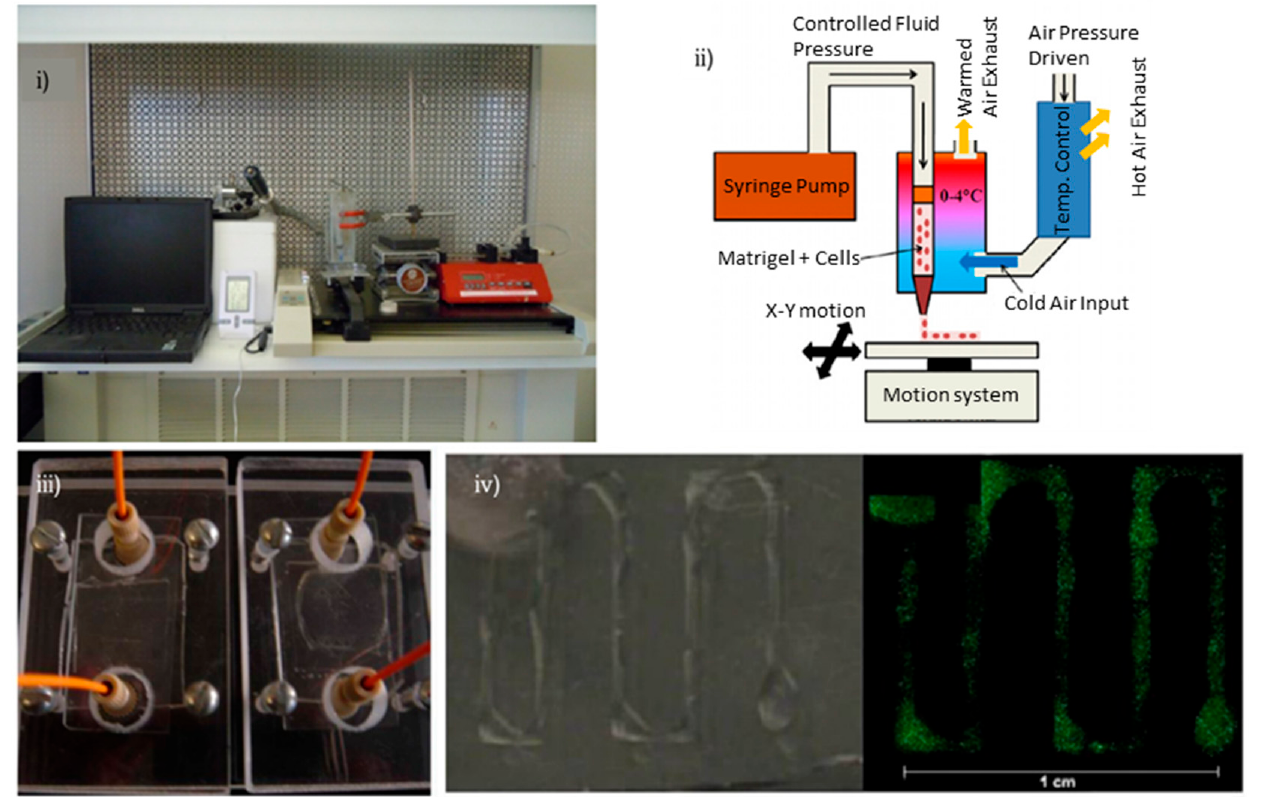
Figure 7. Bioprinted liver-on-chip for drug conversion and radiation protection studies: ( i ) photograph and ( ii ) schematic of the temperature-controlled printing system, ( iii ) microfluidic chip containing cell-laden liver constructs, ( iv ) printed cells. Reprinted and edited with permission granted by Copyright Clearance Center, Inc. (“CCC”). Published in Biofabrication by IOP Publishing Ltd. Authors: J.E. Snyder et al. Title: “Bioprinting cell-laden Matrigel for radioprotection study of liver by pro-drug conversion in a dual-tissue microfluidic chip” [81].